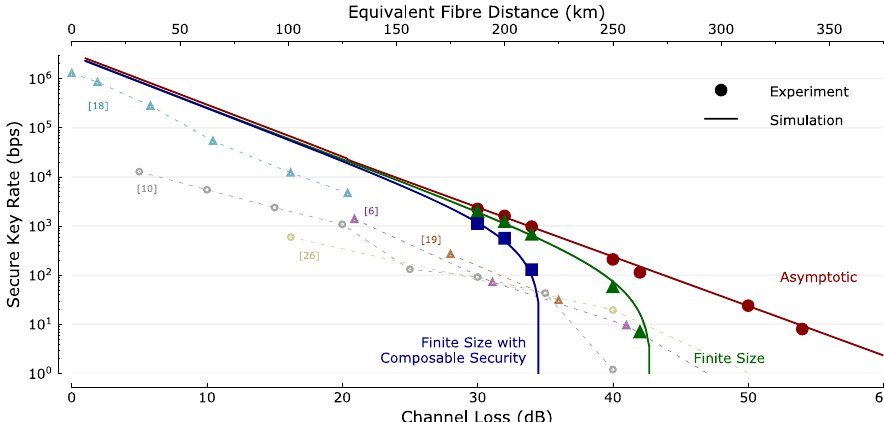
Fig. 5 MDI-QKD system performance. Secure key rate with respect to total channel loss (and equivalent distance in ultra-low loss 0.16 dB km − 1 fi bre) is shown for the asymptotic (circular markers), fi nite size (triangular markers) and fi nite size with composable security (square markers) analyses. Our experimental data ( fi lled markers) are in good agreement with numerical simulations (solid lines) based on our experimental parameters. State-of-the-art results from literature are also shown using un fi lled markers 6,10,18,19,26